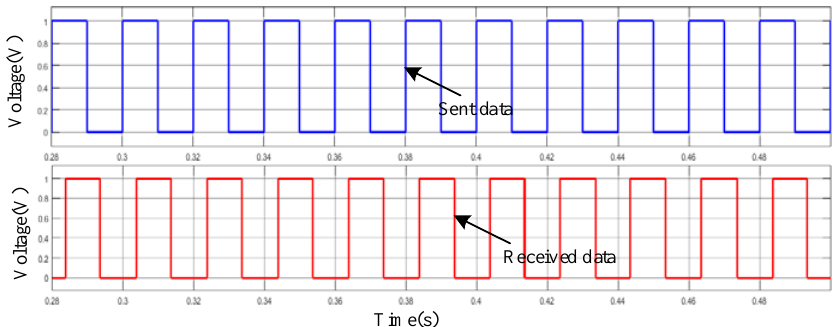
Figure 20. Frequency spectrum for DC-bus current signals.